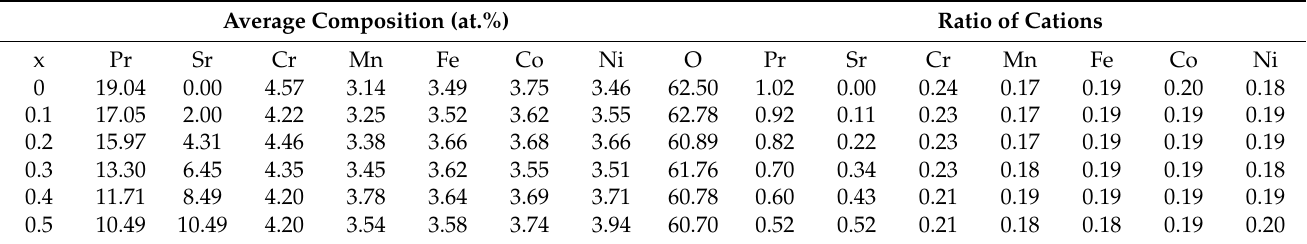
Table A4. Average composition of Pr 1– x Sr x (Cr,Mn,Fe,Co,Ni)O 3– δ ( x = 0–0.5) obtained on an effec- tive area of 200,000 µm 2 by a lithium-drifted silicon detector.